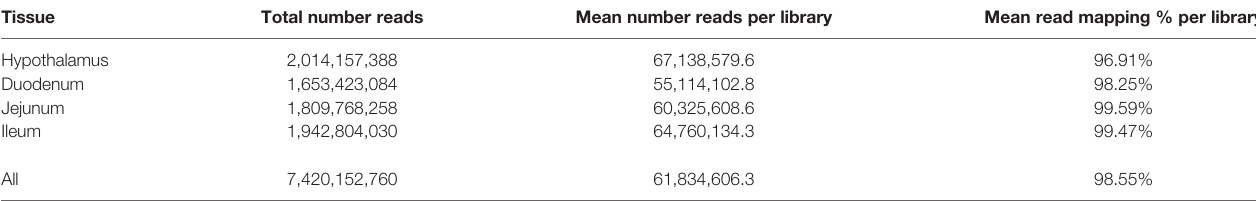
TABLE 2 | Summary of sequencing statistics by tissue.